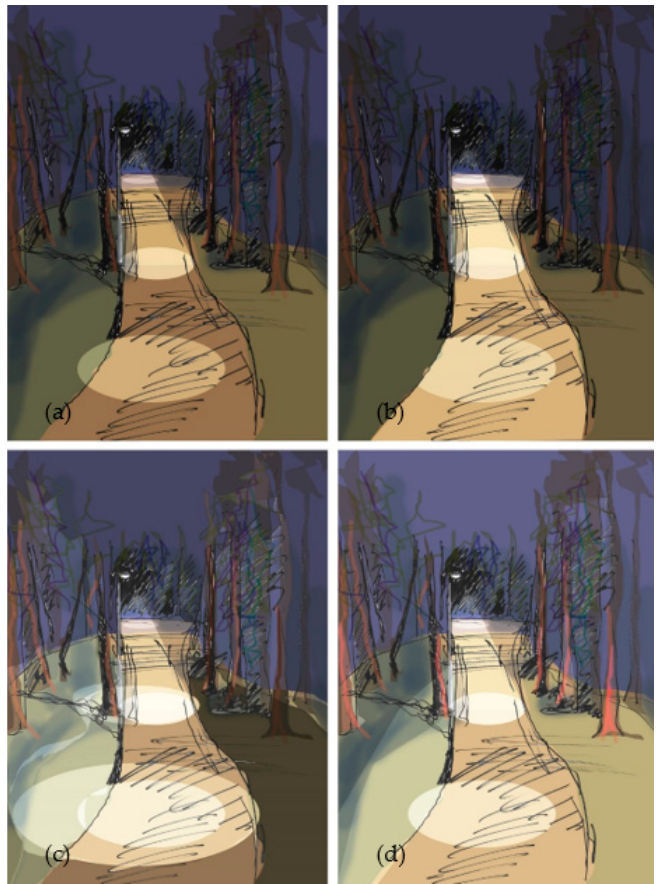
Figure A1. Reflective sketches from Råslätt, showing possible implications from lighting variations (from left to right, top to bottom): ( a ) A somewhat non-uniform lighting, which creates light zones and visual guidance. ( b ) More uniform lighting that emphasizes the pedestrian walkway. Such lighting can be exposing, and the surrounding receives less attention. ( c ) The light zones reach behind the poles. It makes it harder to hide in the foliage. ( d ) A major part of the ground and the trees are illuminated, by the street lighting. There are both horizontal and vertical light—this is how the lighting looks today.